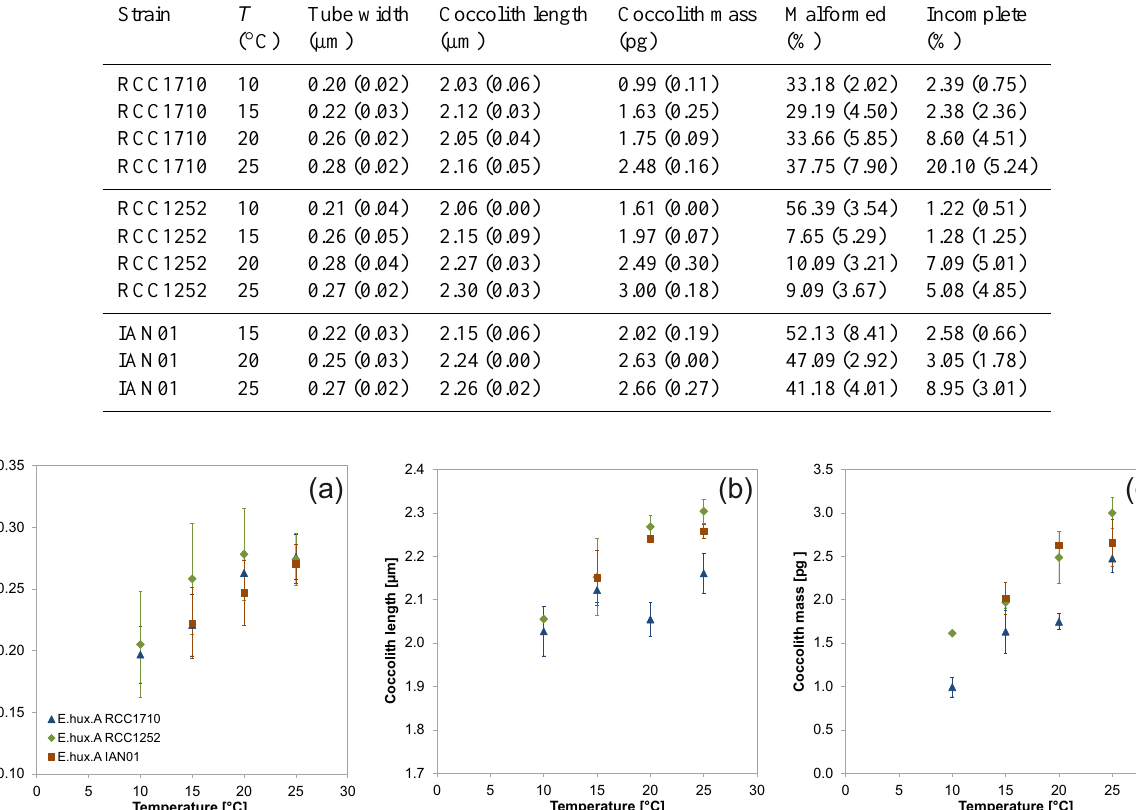
Figure 5. Changes in coccolith morphometry (a, b) and mass (c) , at different temperatures. Standard deviations of the triplicate experiment results are shown. Three different strains of E. huxleyi were